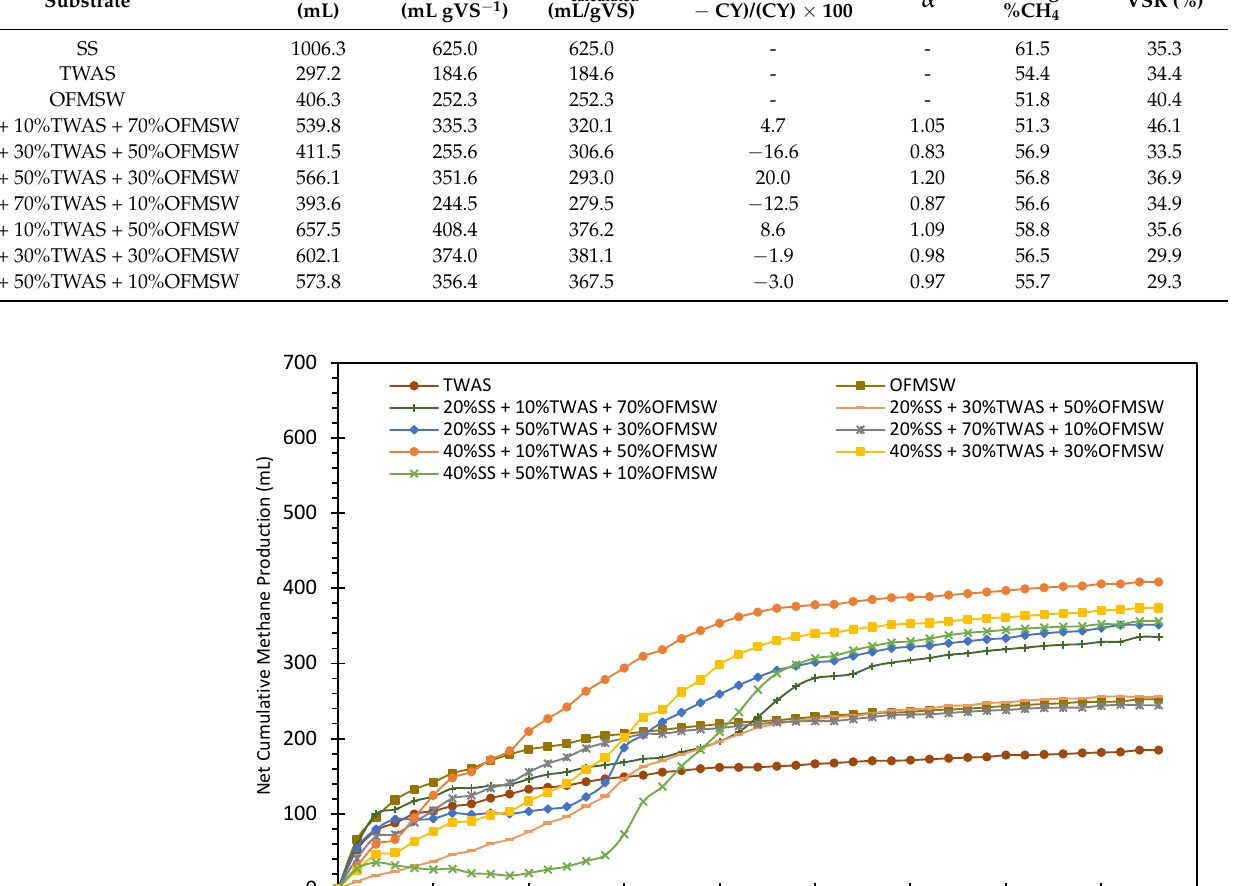
Table 3. BMP test results in both mono ‐ digestion and co ‐ digestion experiments.